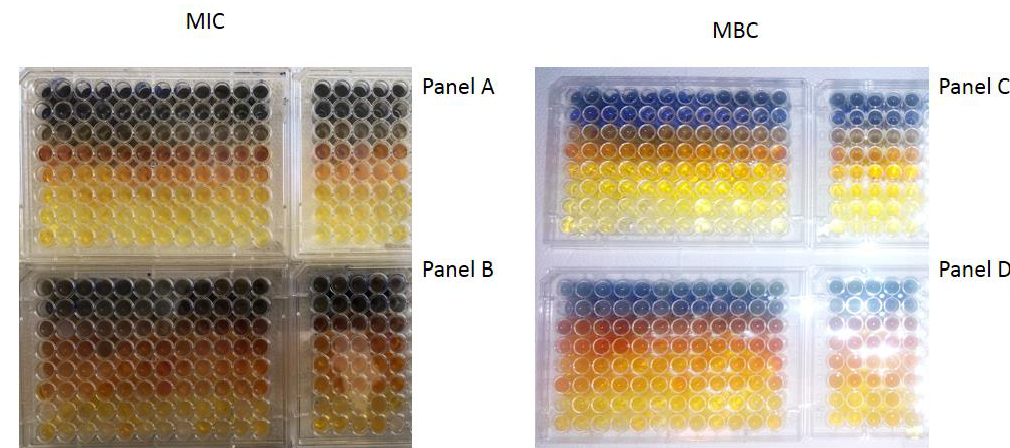
Figure 8. Virus particle analysis using MIC and MBC tests ( A : healthy volunteers), ( B : infected individuals with SARS-CoV-2). MBC analysis of tested viral particles ( C : healthy volunteers) and ( D : infected individuals with SARS-CoV-2. Lanes from 1 to 17 — viral particles with serial dilutions after Salistat SGL03 treatment.